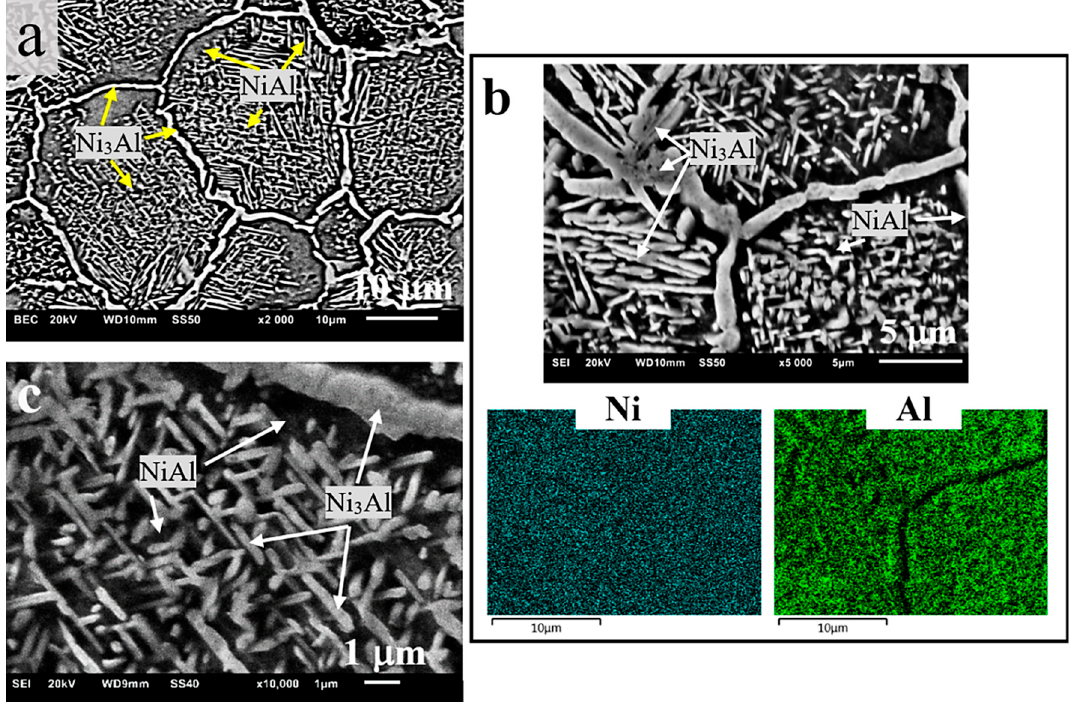
Figure 4. Microstructure of the NiAl sinter at various magnifications: ( a ) BSE (backscattered electrons) micrographs, ( b ) EDS mapping analysis, ( c ) non-uniform intragranular precipitates of Ni 3 Al.